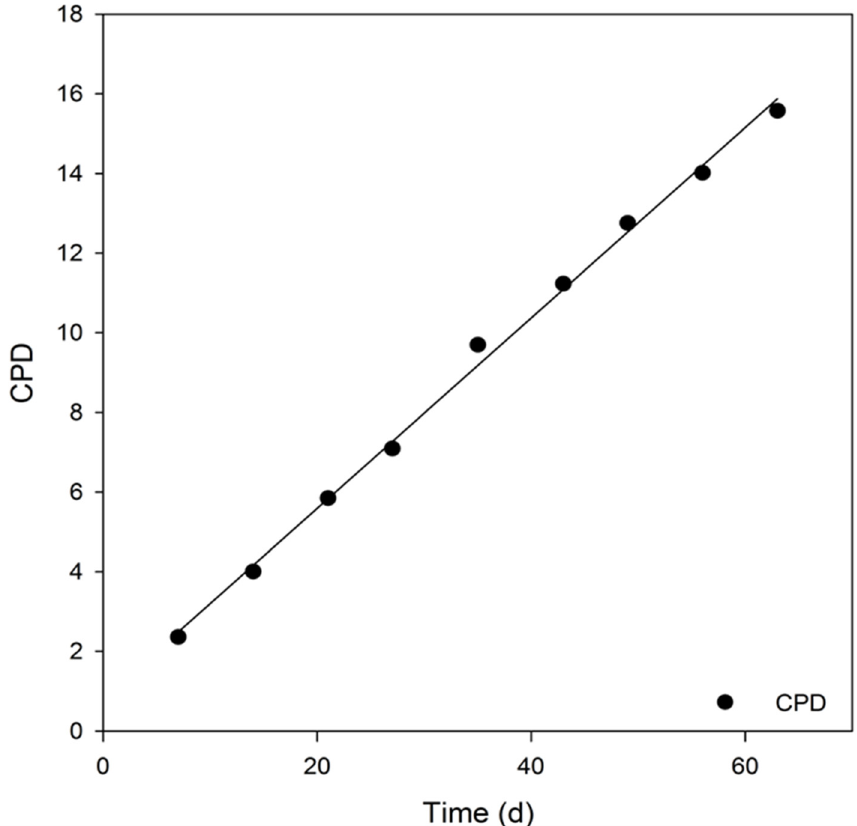
Figure 8. Cumulative population doubling (CPD) of SH-SY5Y over a cultivation period of 63 days. (Regression coefficient: r 2 = 0.9969.)